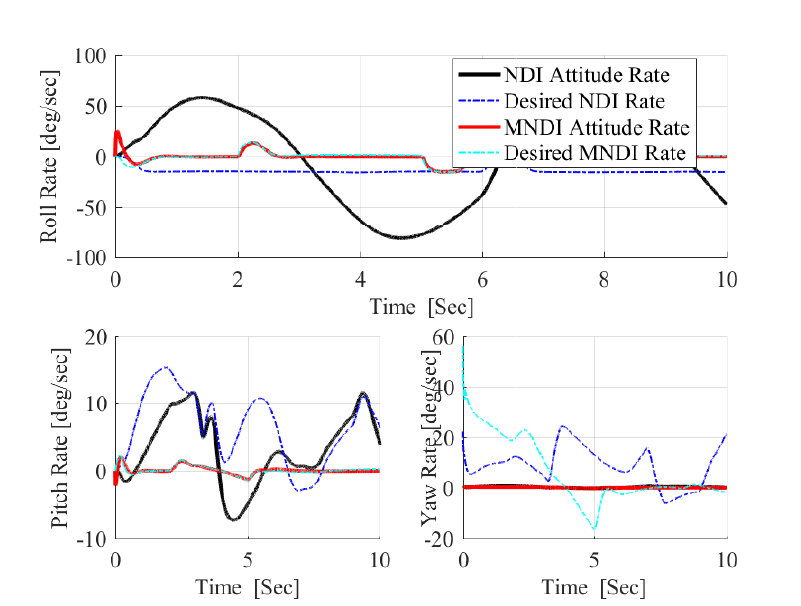
Figure 18. Attitude angle error for outer roll angle excitation with wind and uncertainties.